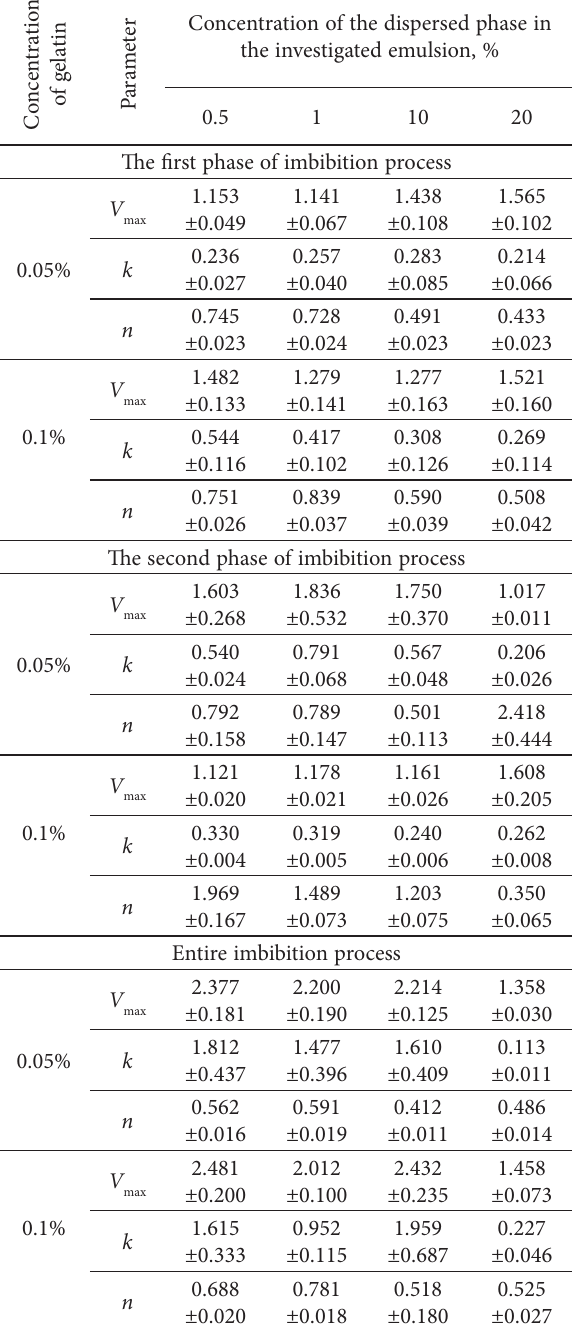
Table 4. Parameters for the Hill equation